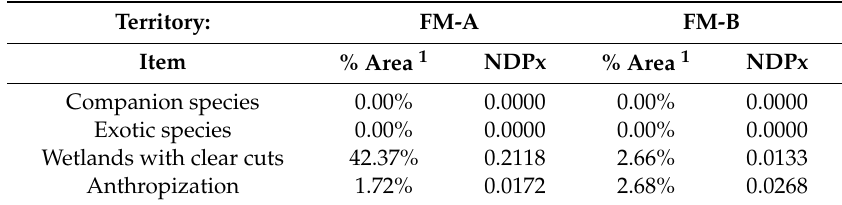
Table A5. Naturalness degradation potential for companion species (CS_NDP), exotic species (exo_NDP), wetlands with clear cuts (W_CC_NDP) and anthropization (ANT_NDP) in Montmorency